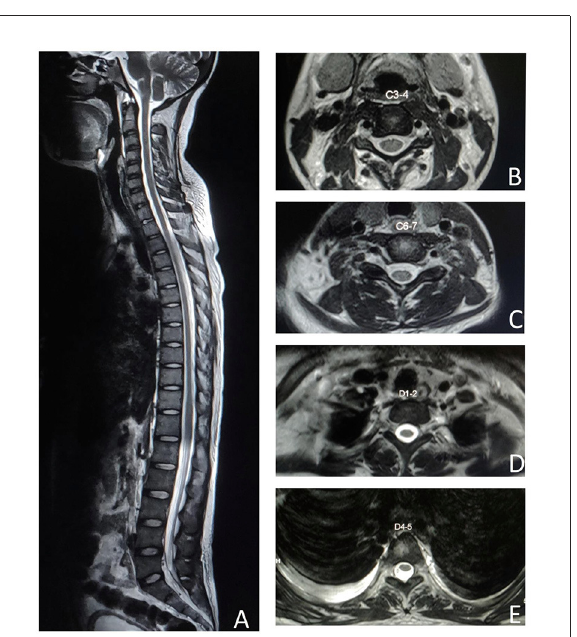
FIGURE2 MRI spine T2 weighted image shows no spinal cord signal changes in the sagittal section (A) , cervical axial sections at C3–4 (B) , C6–7 (C) , dorsal axial sections at D1–2 (D) , and D4–5 (E) .